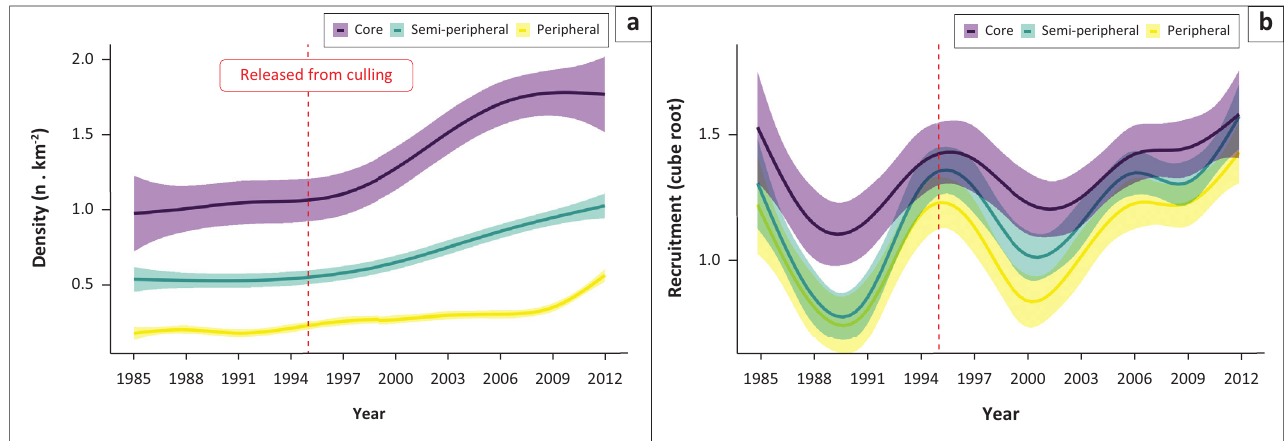
FIGURE 3: Deterministic component of Stochastic Ricker growth models (Eqn 3) fitted to time series of elephant population in the Kruger National Park (1996–2012). Models shown for overall population (a), and separately for the three zones in the park; peripheral (b), semi-peripheral (c) and core (d). Test for negative density